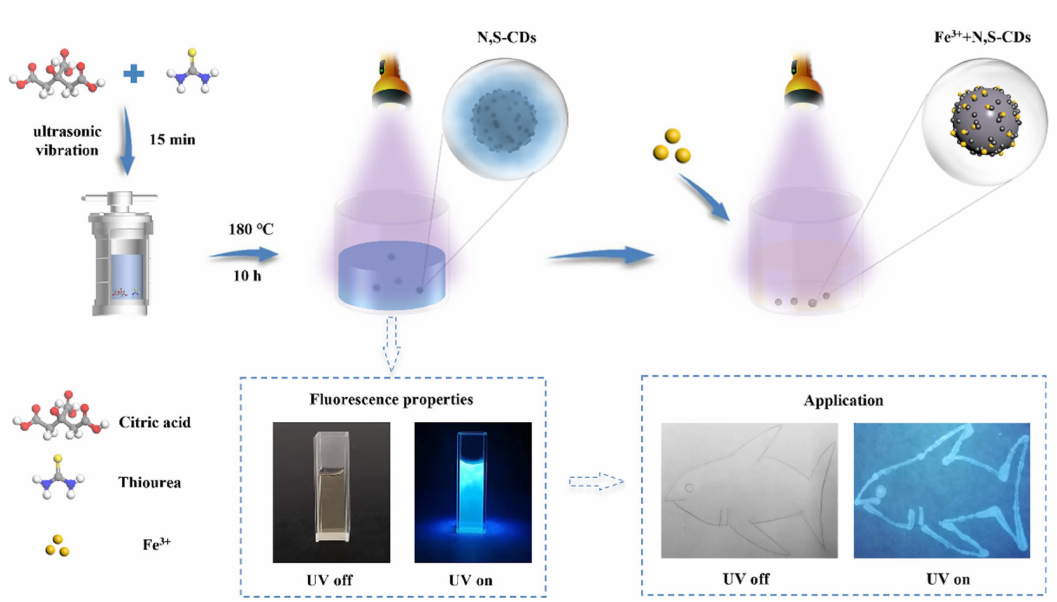
Figure 1. Schematic diagram of the preparation and application of N,S-CDs and their application in Fe 3+